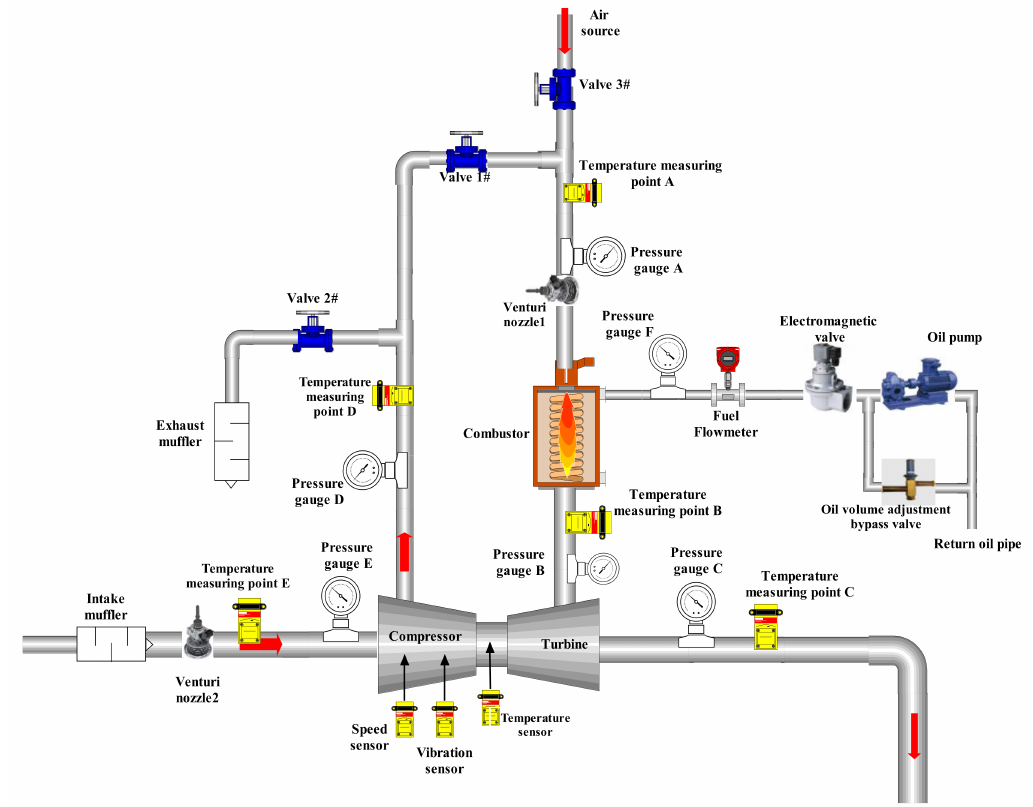
Figure 1. Schematic diagram of the test